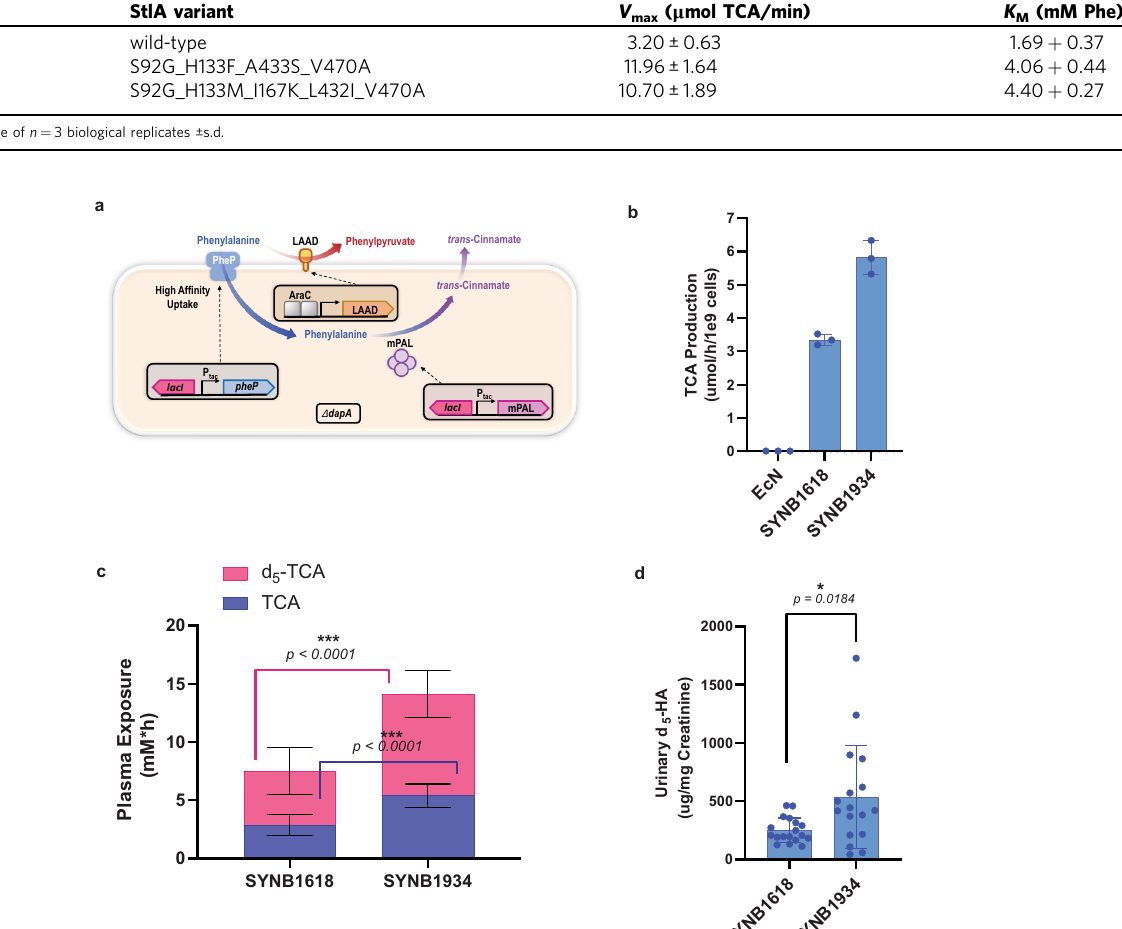
Table 1 Michaelis – Menten parameters from lysate kinetic data. Strain